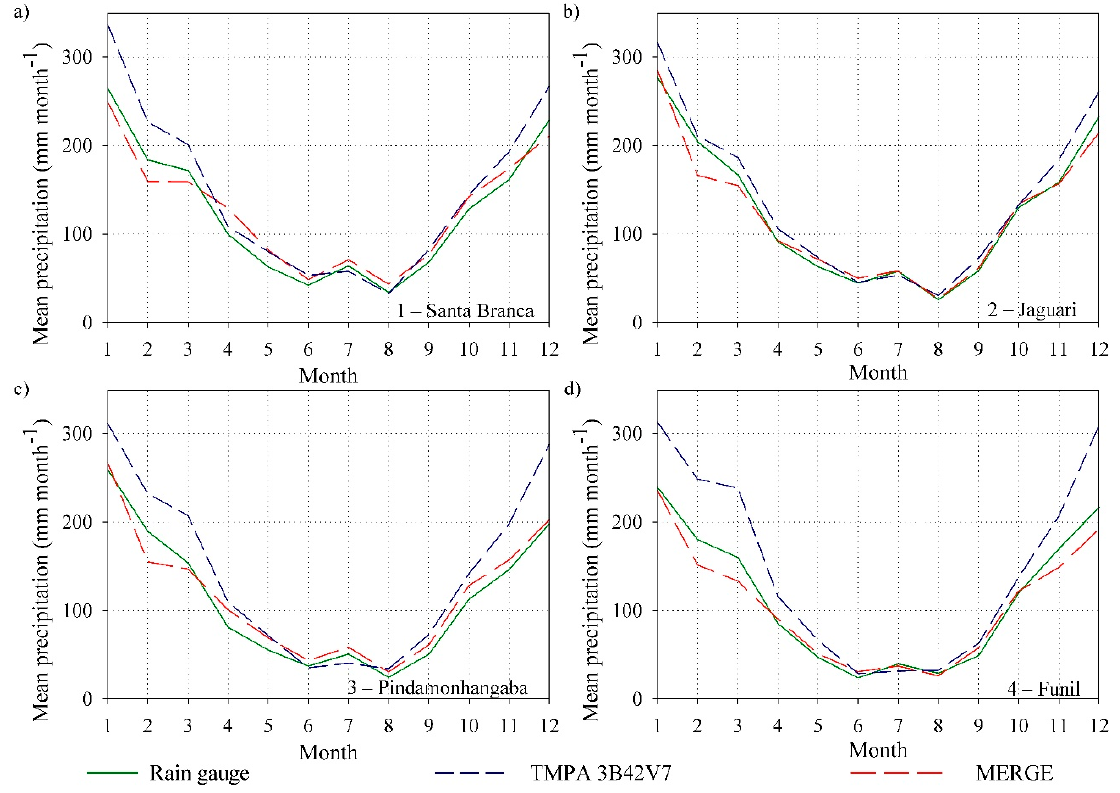
Figure 4. Mean monthly precipitation for watersheds ( a ) 1, ( b ) 2, ( c ) 3, and ( d ) 4.